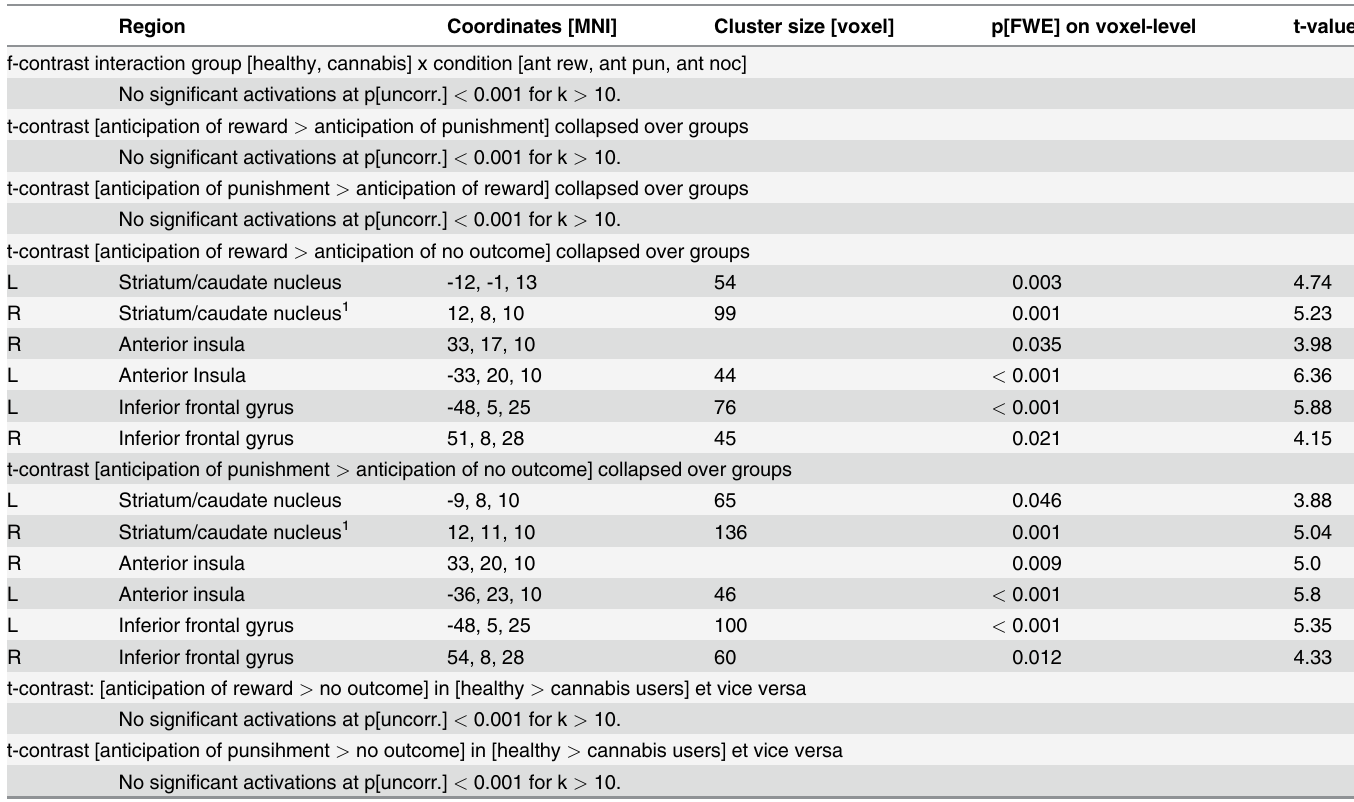
Table 2. List of activations related to the anticipation